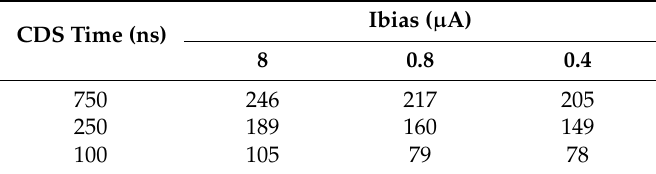
Table 2. Measured average SF read noise ( μ Vrms) for selected t CDS (ns) and SF Ibias ( μ A).